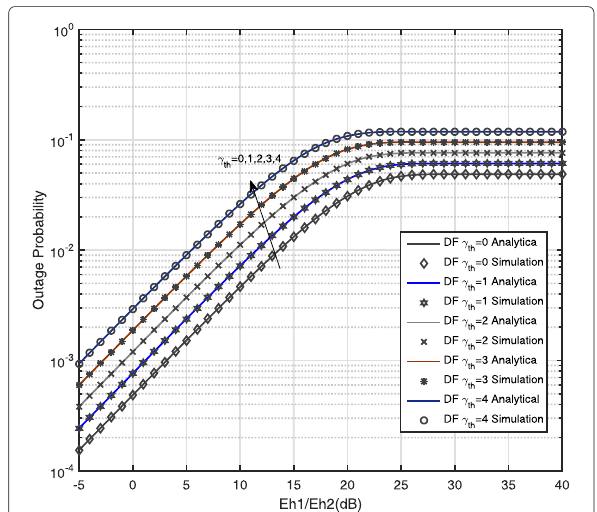
Fig. 6 Outage probability versus E h 1 for E h 2 = E h 3 with DF